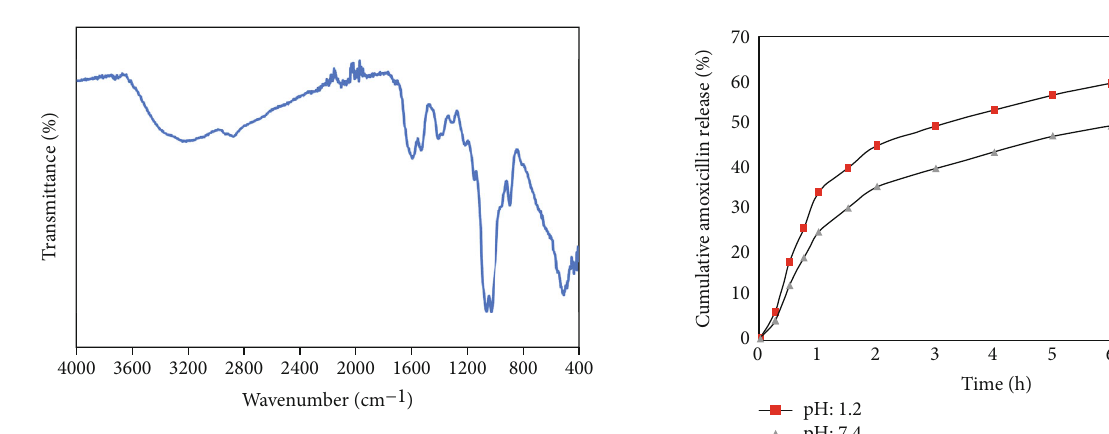
Figure 3: Fourier transform infrared (FTIR) spectrum of the as-synthesized Cs-Al NDs.